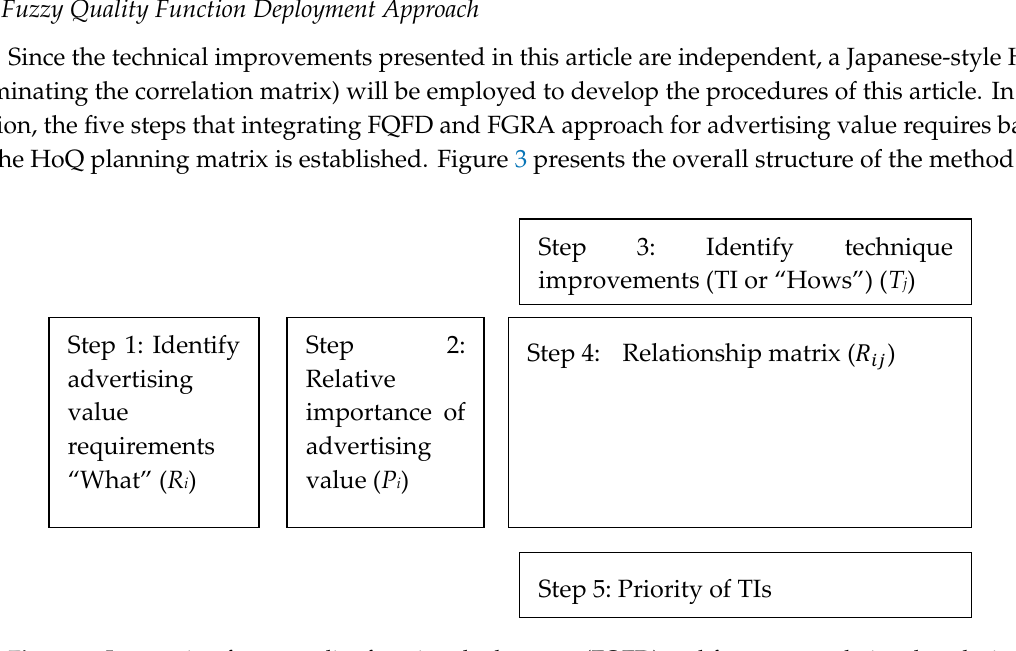
Figure 3. Integrating fuzzy quality function deployment (FQFD) and fuzzy grey relational analysis (FGRA) approach for advertising effectiveness improving.